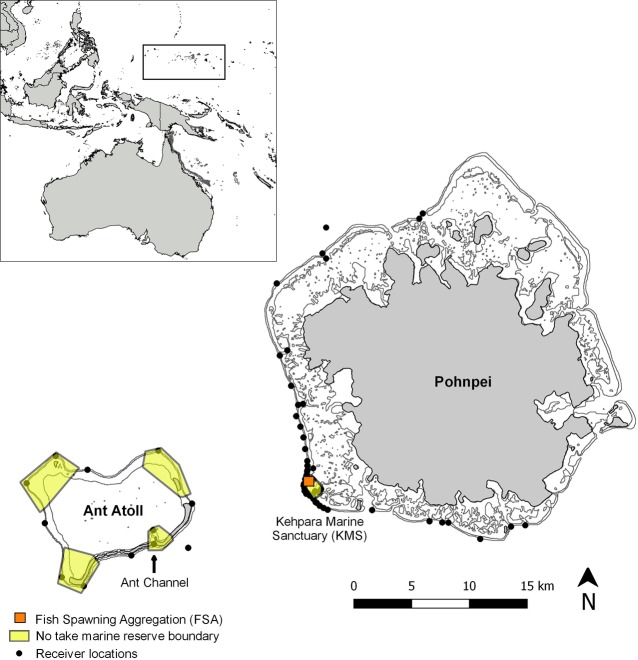
Map of the study site.Pohnpei and Ant Atoll, Federated States of Micronesia showing receiver locations. Boxes with yellow shading indicate the boundaries of no-take marine reserves and land masses are shaded grey. Orange boxes denote fish spawning aggregation (FSA) sites.